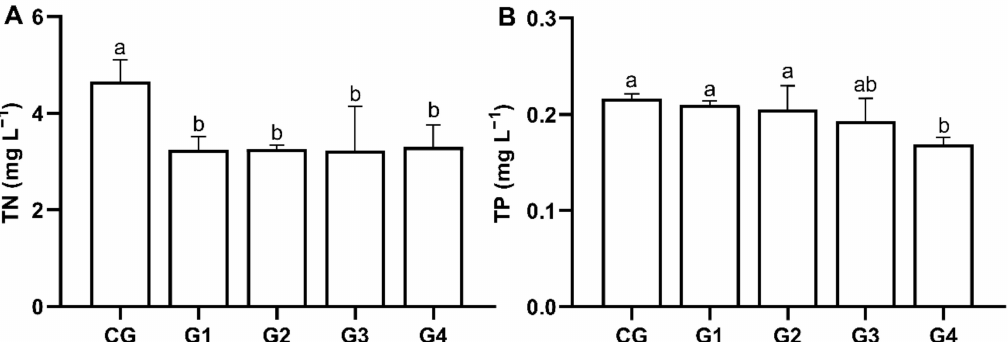
Figure 4. Total nitrogen (TN) ( A ) and total phosphorus (TP) ( B ) in different mussel density treatments. Note: CG, G1, G2, G3 and G4 represent 0 mussels, 3 mussels, 6 mussels, 9 mussels and 6 mussels, respectively. Different lowercase letters denote significant difference between different treatments ( p <